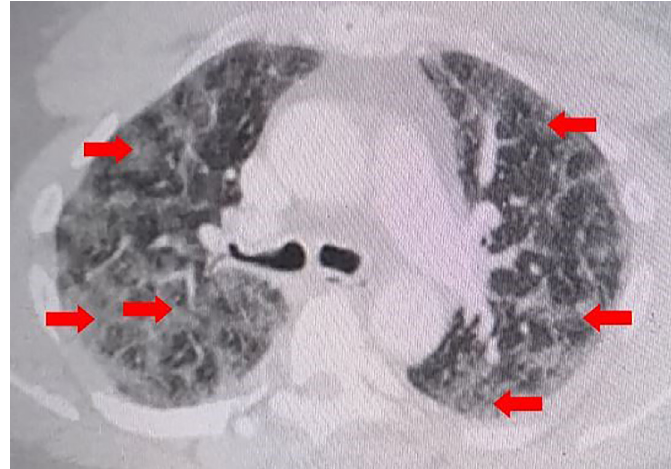
Image 1. Initial chest radiograph demonstrating mild pulmonary vascular congestion with mild, hazy bilateral airspace disease, likely secondary to alveolar edema or aspiration (arrows).